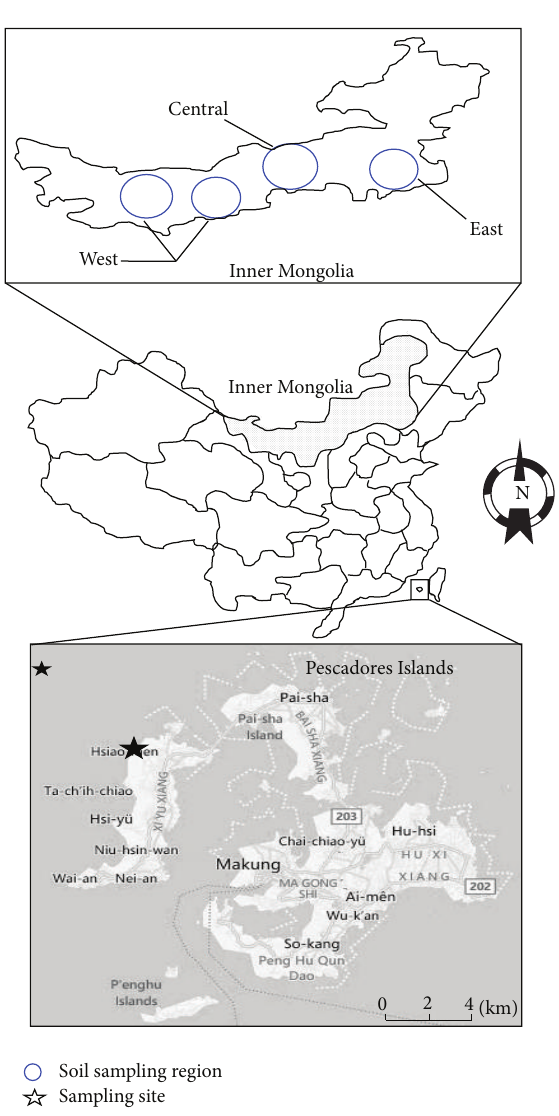
Figure 1: Location of atmospheric particles ( 󳀅 ) at the Pescadores Islands and soil source regions ( I ) in the Inner